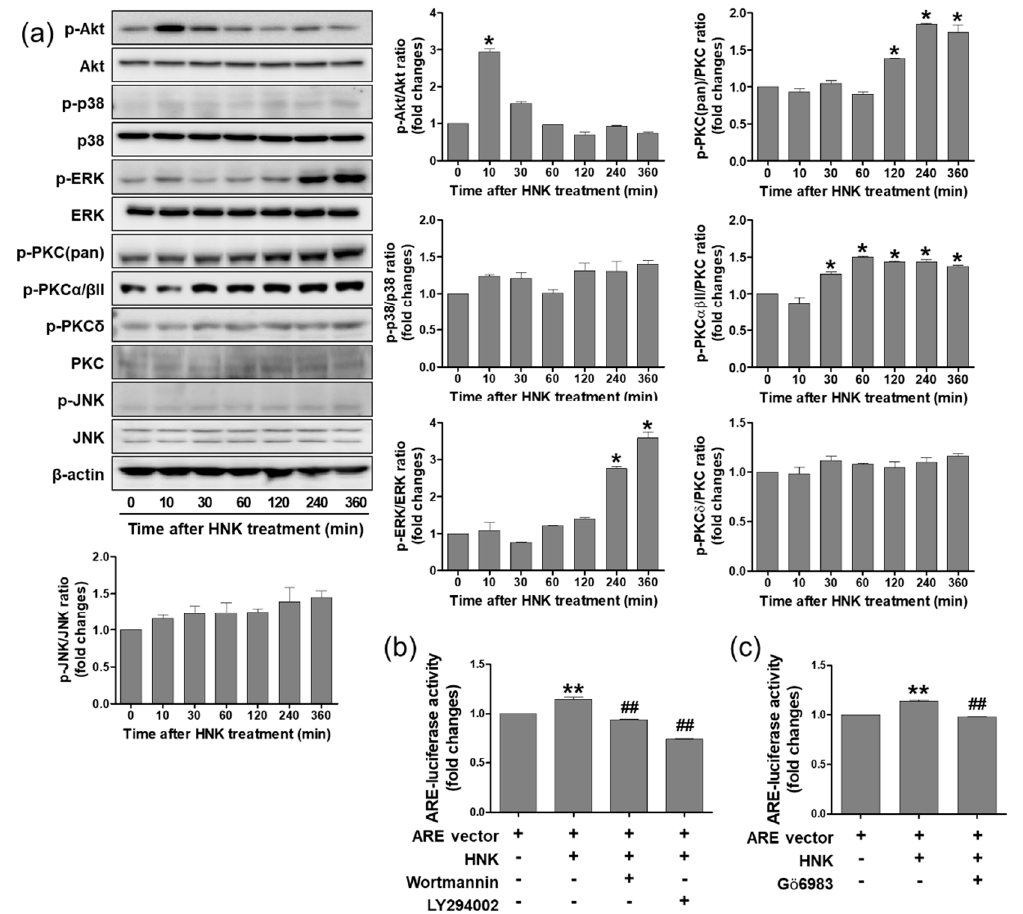
Figure 4. Honokiol regulates Nrf2 activation through phosphoinositide 3-kinase (PI3K) / Akt and protein kinase C (PKC) signaling pathway in HK-2 cells. ( a ) Cells were treated with honokiol (2 µ M) for 0, 10, 30, 60, 120, 240, or 360 min. The cell lysates were subjected to western blot analysis using anti-p-Akt, anti-p-p38, anti-p-JNK, anti-p-ERK, anti-p-PKC (pan), anti-p-PKC α / β II, anti-p-PKC δ , and anti- β -actin antibodies. ( b , c ) Cells were transfected with ARE-luciferase plasmid (1 µ g) and treated with inhibitors of Wortmannin (100 nM), LY294002 (10 µ M), or Gö6983 (10 nM) for 30 min, prior to honokiol (2 µ M). After 4 h incubation, the ARE-luciferase activity was measured by a luciferase reporter assay system. Values are expressed as the means ± S.E.M. of three independent experiments. * p < 0.05, ** p < 0.01 significant compared with the vehicle control. ## p < 0.01 significant compared with honokiol alone.